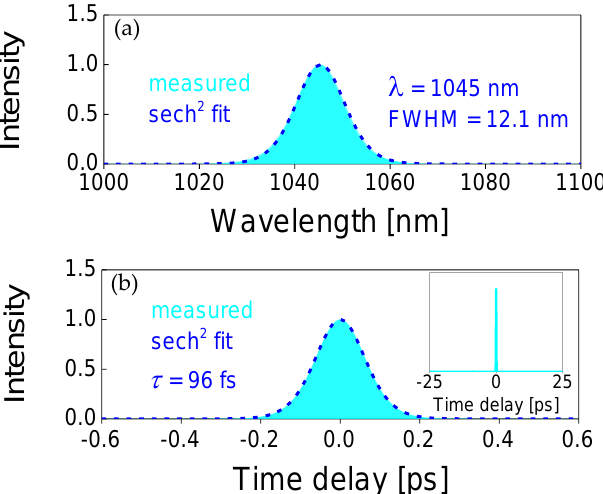
Figure 5. SESAM ML Yb:Ca 3 Gd 2 (BO 3 ) 4 laser with T OC = 2.5%: ( a ) optical spectrum and ( b ) SHG-based intensity autocorrelation trace with a sech 2 fit. Inset : simultaneously measured long-scale SHG-based intensity autocorrelation trace for the time span of 50 ps. The steady-state pulse train corresponding to the shortest pulses achieved was characterized by a radio-frequency (RF) spectrum analyzer. The first beat note was rec- orded at ~67.3 MHz with a resolution bandwidth (RBW) of 300 Hz, as shown in Figure 6a. No spurious modulations could be observed with a signal-to-noise ratio above 76 dBc. evidence for the stable CW mode-locking of the Yb:GdCB laser without any Q-switching or multiple pulsing instabilities.